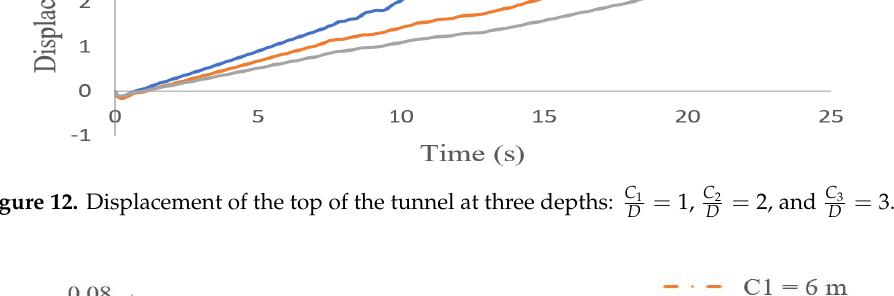
Figure 12. Displacement of the top of the tunnel at three depths: 𝑪 𝟏 The acceleration response curve on the soil surface (at the center line of the model) for a tunnel at different depths (C1 = 6 m, C2 = 12 m, and C3 = 18 m) is shown in Figure 13, illustrating the effect of tunnel depth on the acceleration response of the soil surface. This graph results from a model in which the thickness of the tunnel lining is 0.3 m and the input motion of earthquake is 0.4 g. According to Figure 13, the maximum acceleration response on the soil surface does not change with increasing depth, and the value of maximum acceleration for all depths is approximately 0.06 g.